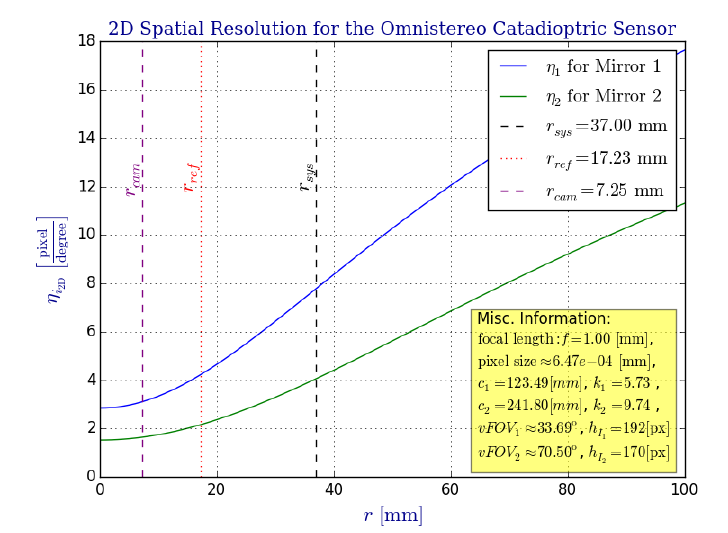
Figure 12. Using the formula given in Equation (60), we plot the 2D version of the spatial resolution of our proposed omnistereo catadioptric sensor (37mm-radius rig). Both resolutions η 1 and η 2 increase towards the equatorial region where they are physically limited by r sys . This verifies the spatial resolution theory given in [29], and it justifies our coaxial configuration useful for omnistereo sensing within the SROI indicated in Figure